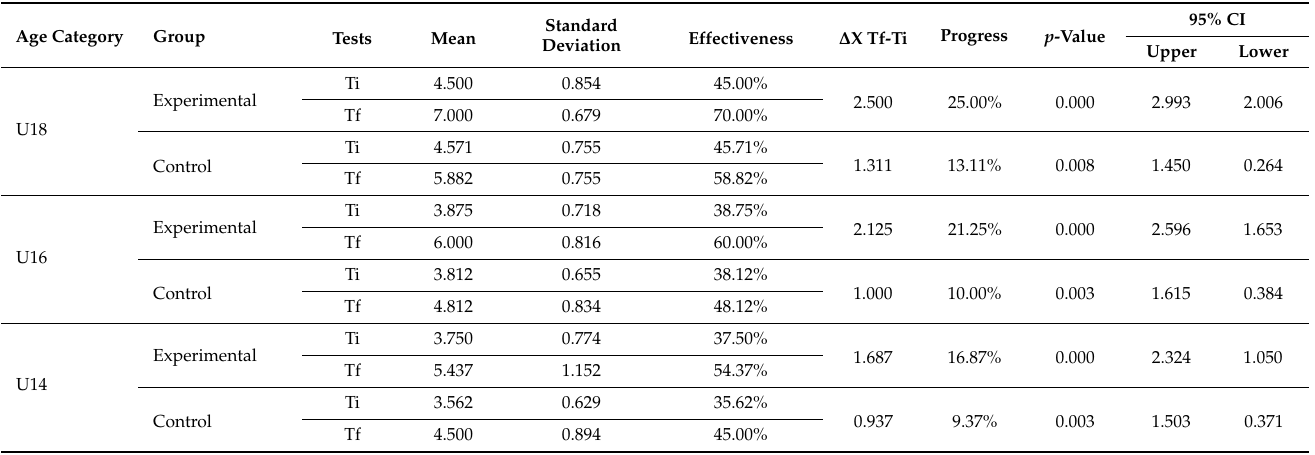
Table 5. Descriptive statistics for the 10 experimental throws test for the U14, U16, and U18 male experimental